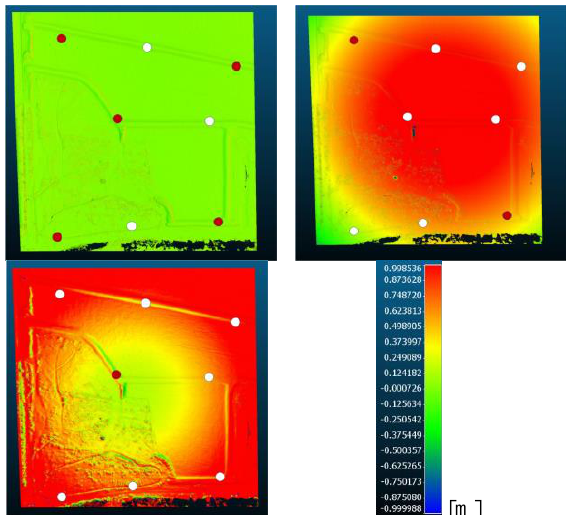
Figure 10. Comparison of point clouds from RealityCapture; top left: 5 GCPs; top right: 2 GCPs; bottom left: 1 GCP